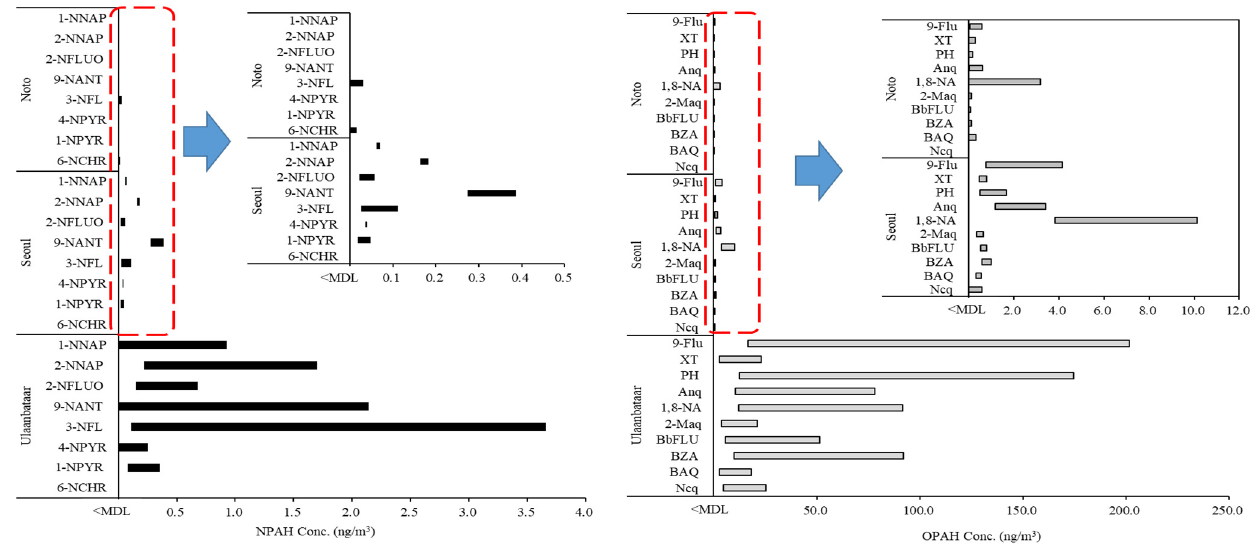
Figure 6. Concentration ranges of individual NPAH and OPAH congeners in PM 2.5 from real sam- ples.